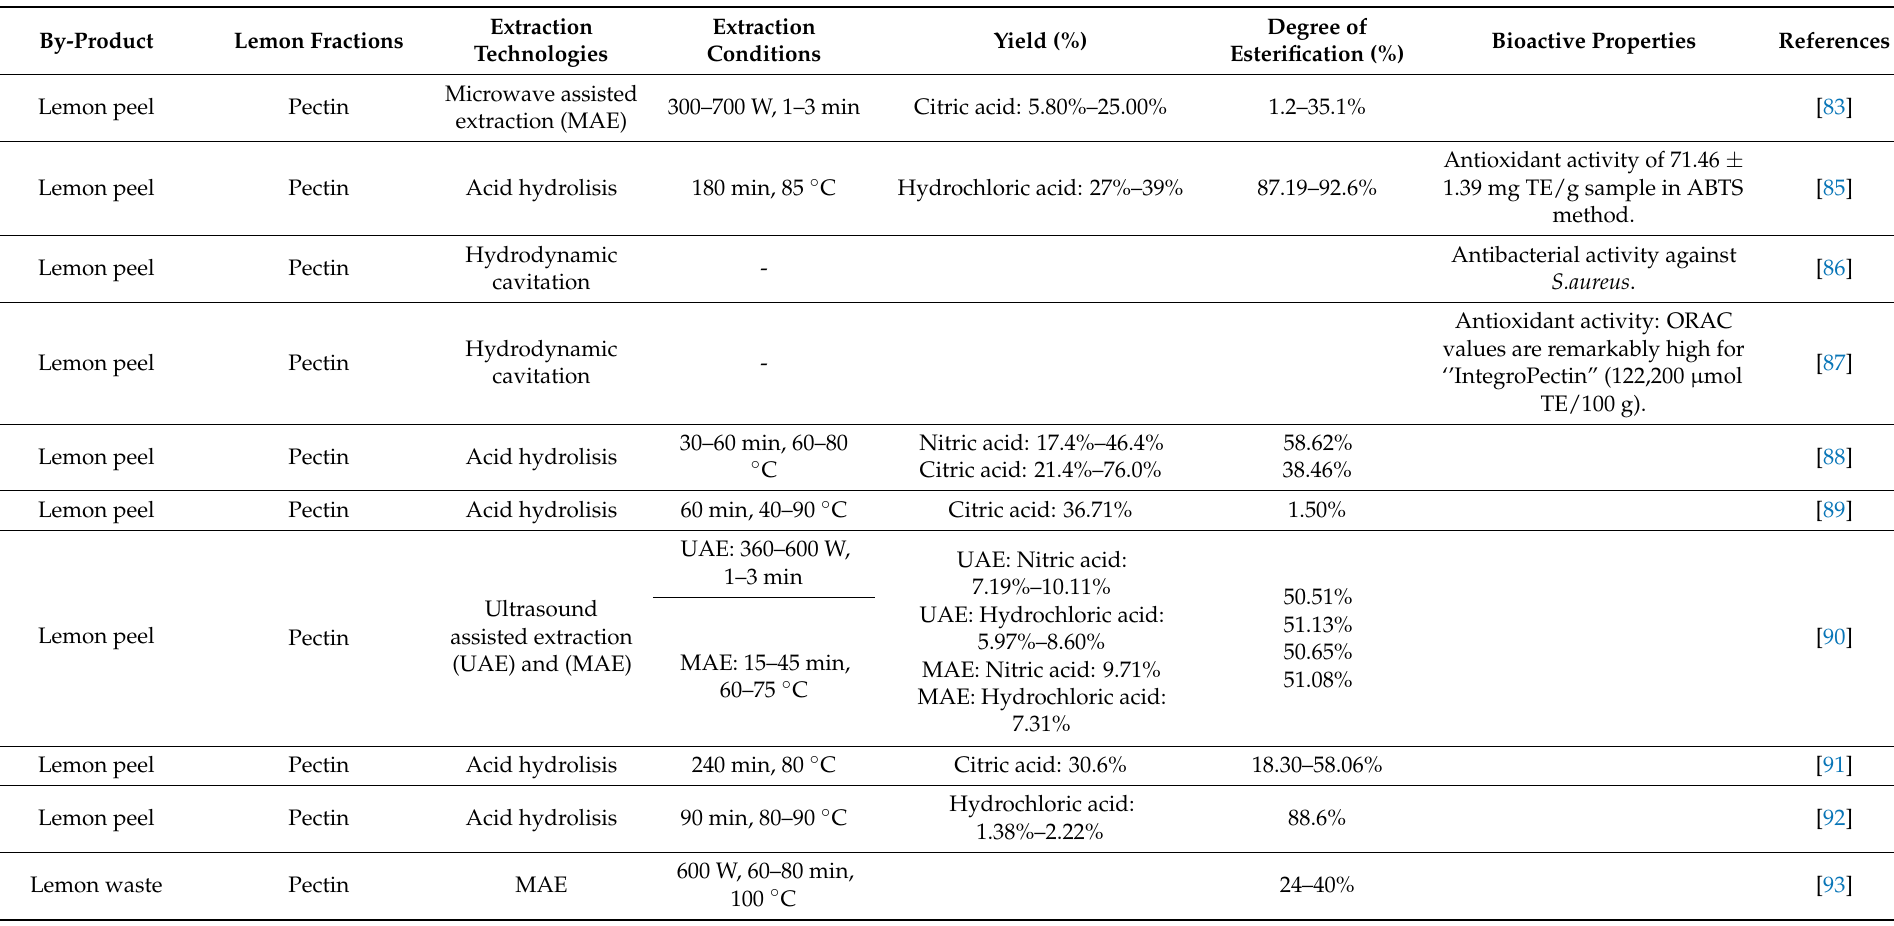
Table 6. Extraction technologies and bioactive properties of pectin from lemon